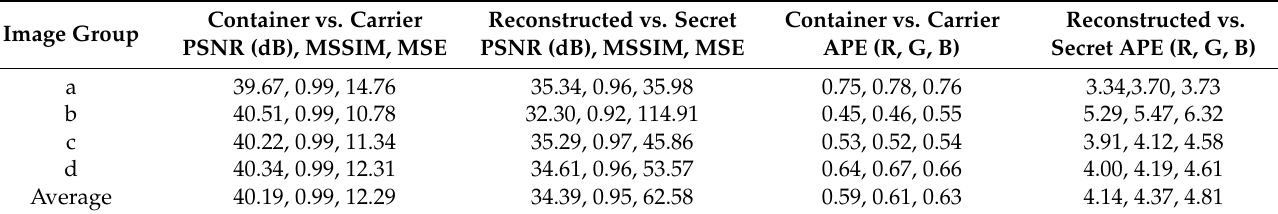
Table 1. PSNR (dB) and images of MSSIM, MSE and APE (R, B, G).